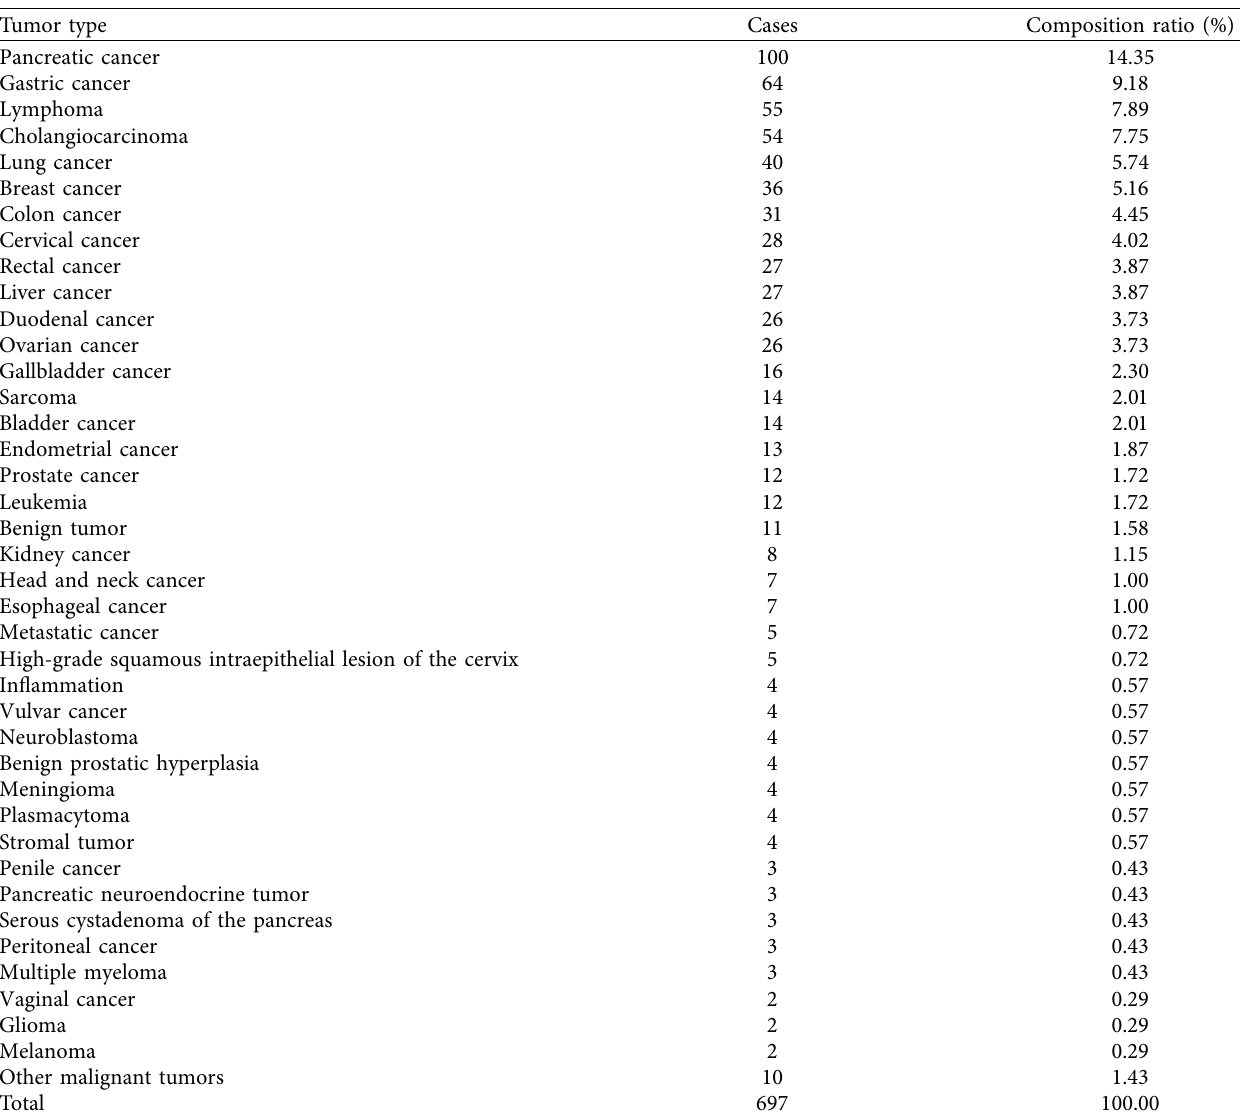
Table 2: Tumor-type distribution of cancer patients complicated with E. coli